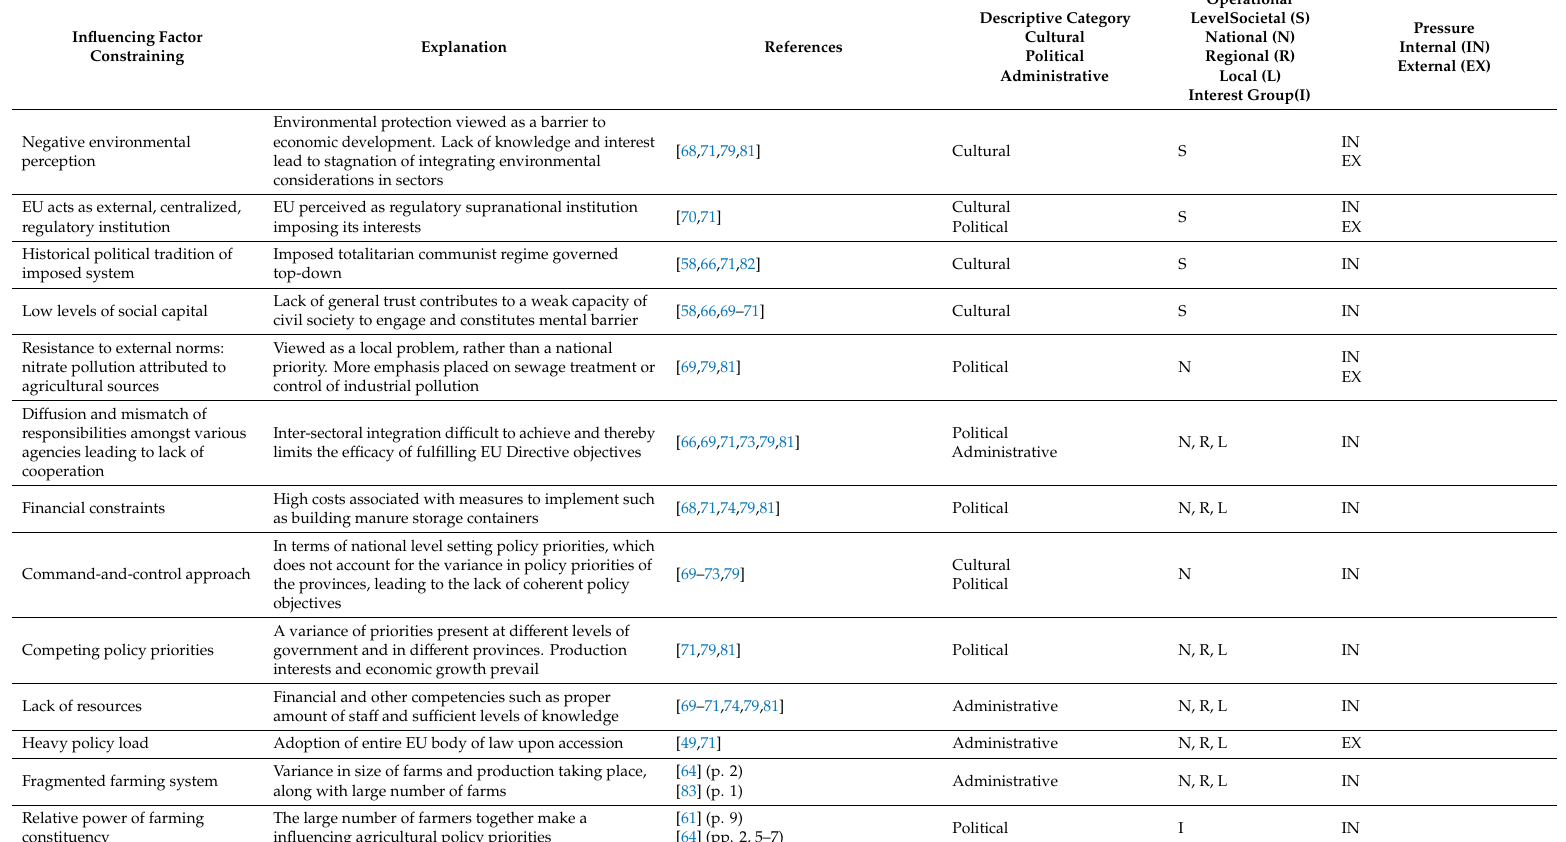
Table 2. Constraining factors identified in component 1 of analysis for the evaluation of governance